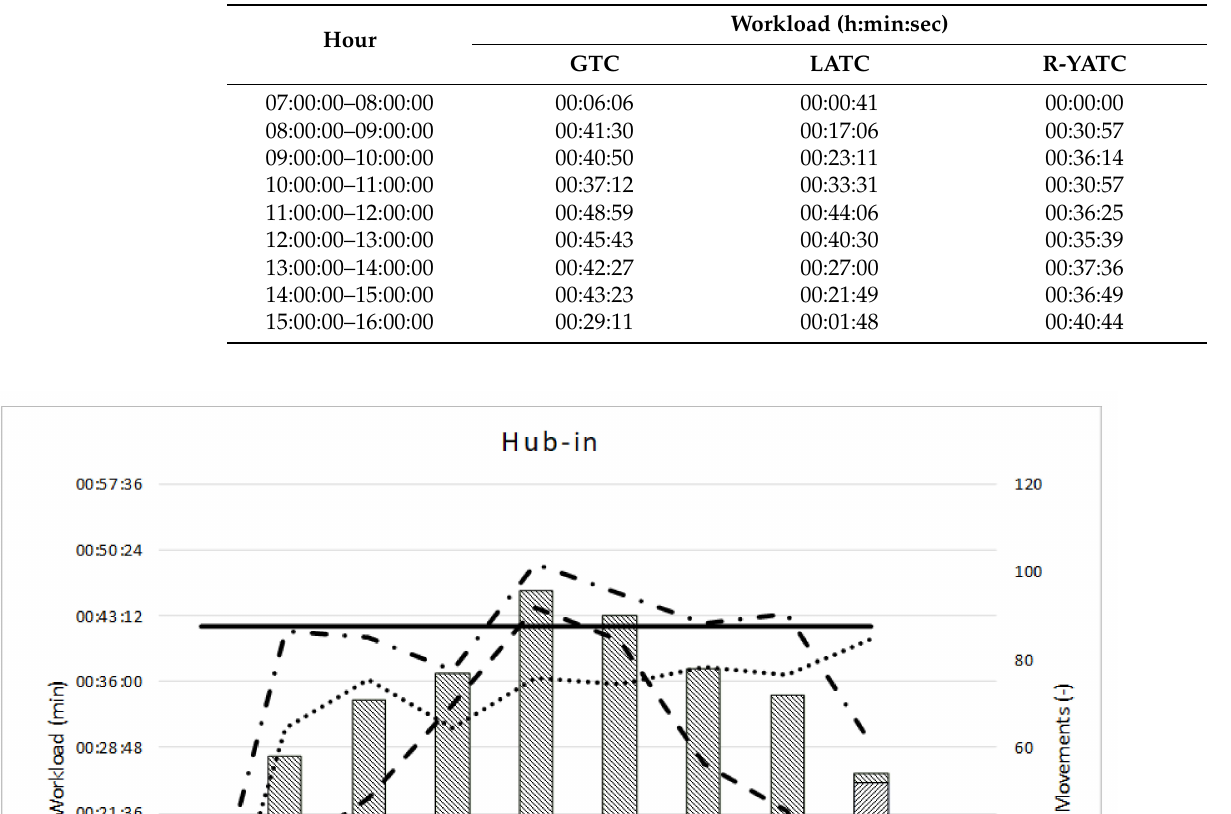
Table 7. Hub-in workload.